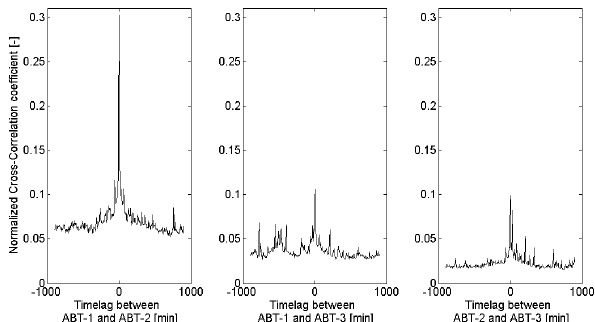
Fig. 7: Cross-correlation coefficients of the 5-min ebullition rates versus the time lag of the three ABTs against 624 each other. Peaks at zero lag indicate that both signals are synchronized. 625 Figure 7. Cross-correlation coefficients of the 5min ebullition rates versus the time lag of the three ABTs against each other. Peaks at zero lag indicate that both signals are